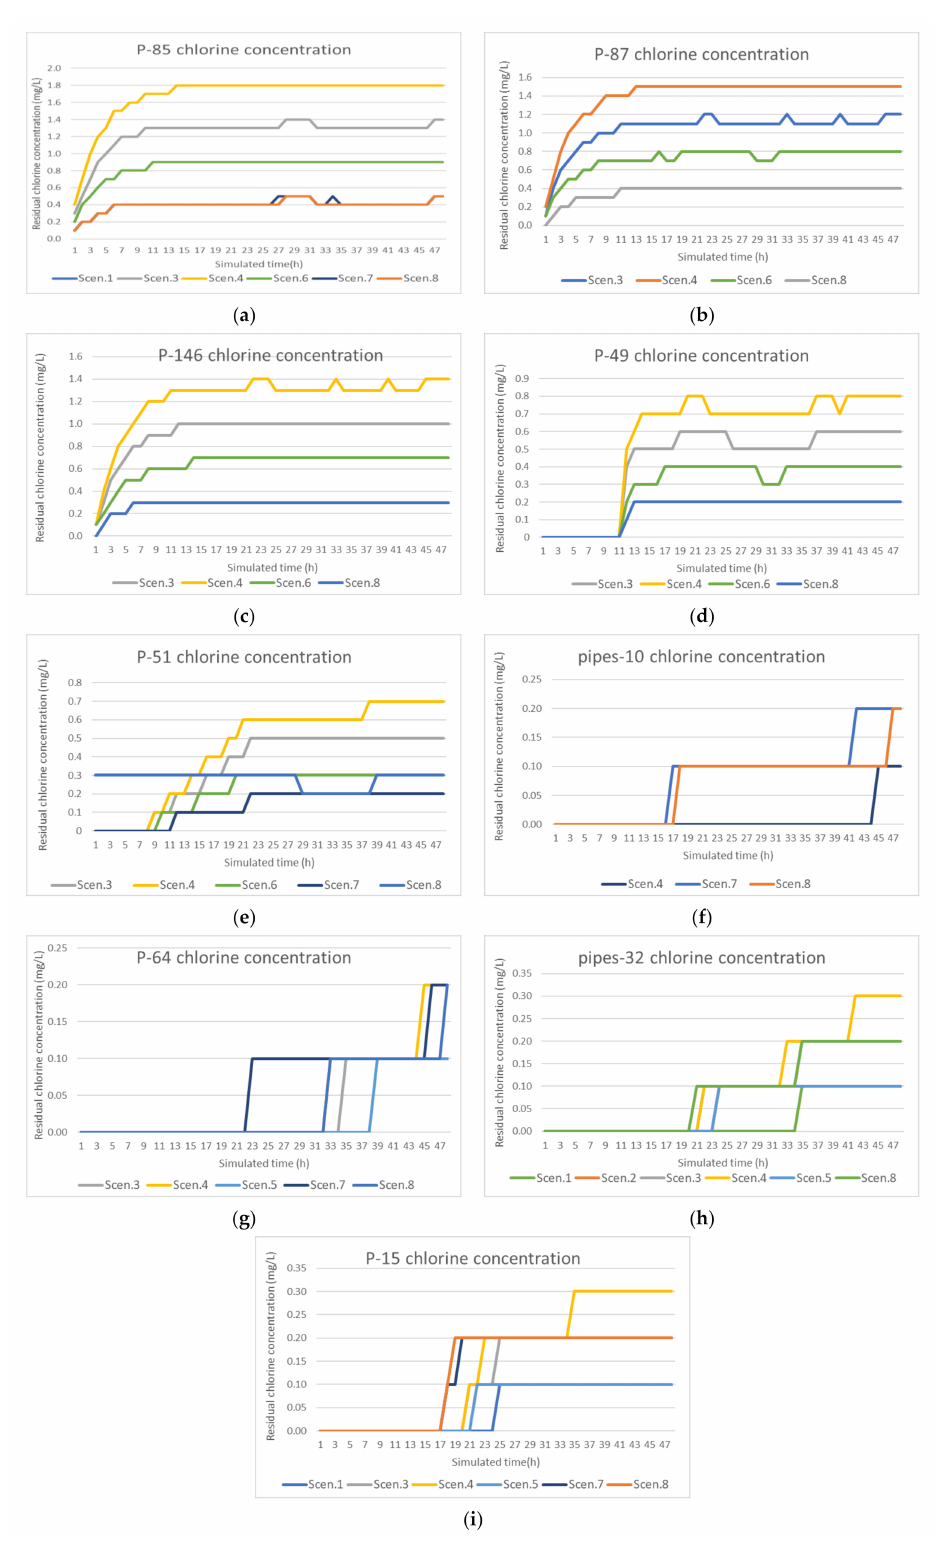
Figure 5. Residual chlorine concentration (mg/L) at the selected pipes during 48 h of operation (Scenario A). Specifically: ( a ) P-85; ( b ) P-87; ( c ) P-146; ( d ) P-49; ( e ) P-51; ( f ) pipes-10; ( g ) P-64; ( h ) pipes-32; and ( i )